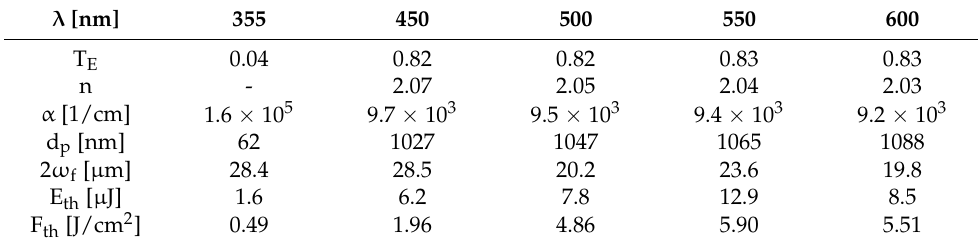
Table 1. Optical parameters (T E , n, α , d p ) at the utilized λ calculated from the transmittance data by the method of Swanepoel (Figure 2a) [26], as well as ablation parameters for single-beam ablation (E th , 2 ω f , F th ) determined by the method of Liu (Figure 3a)